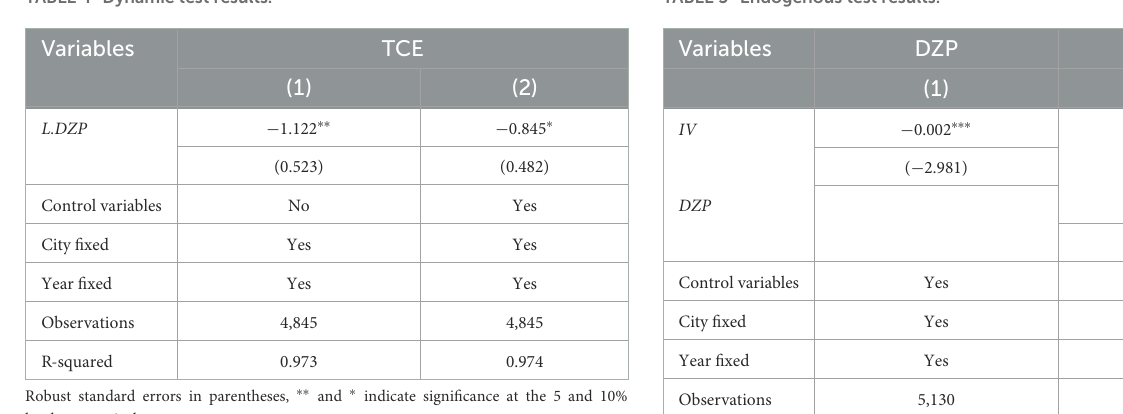
TABLE 4 Dynamic test results. TABLE 5 Endogenous test